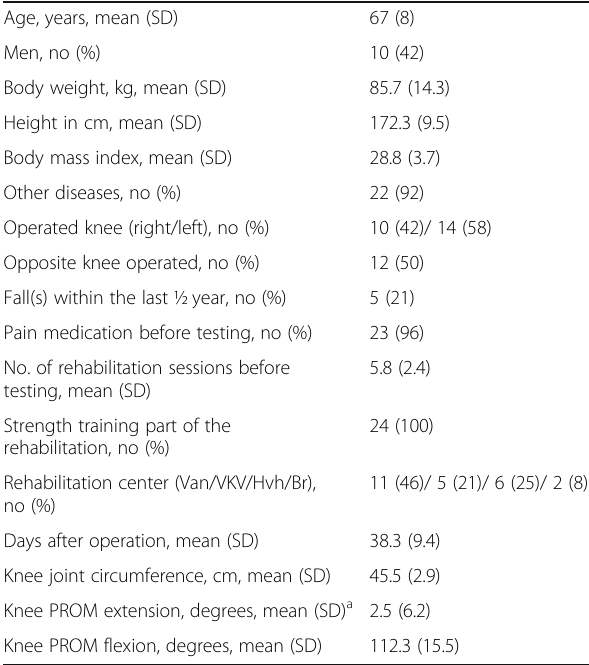
Table 1 Baseline characteristics ( n =